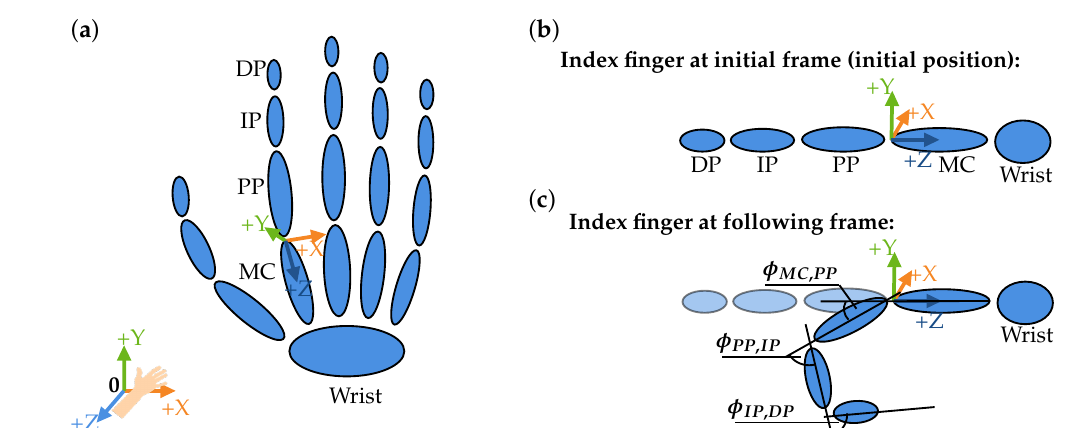
Figure 4. Definition of the joint angles. ( a ) The skeletal structure of a hand. ( b ) The stretched position of the index finger (wrist, metacarpals (MC), proximal phalanges (PP), intermediate phalanges (IP), and distal phalanges (DP)) represents the reference position. ( c ) Angles are calculated in a followed bending position of the index finger. The angles φ MC , PP , φ PP , IP and φ IP , DP represent the angles around the X -axis